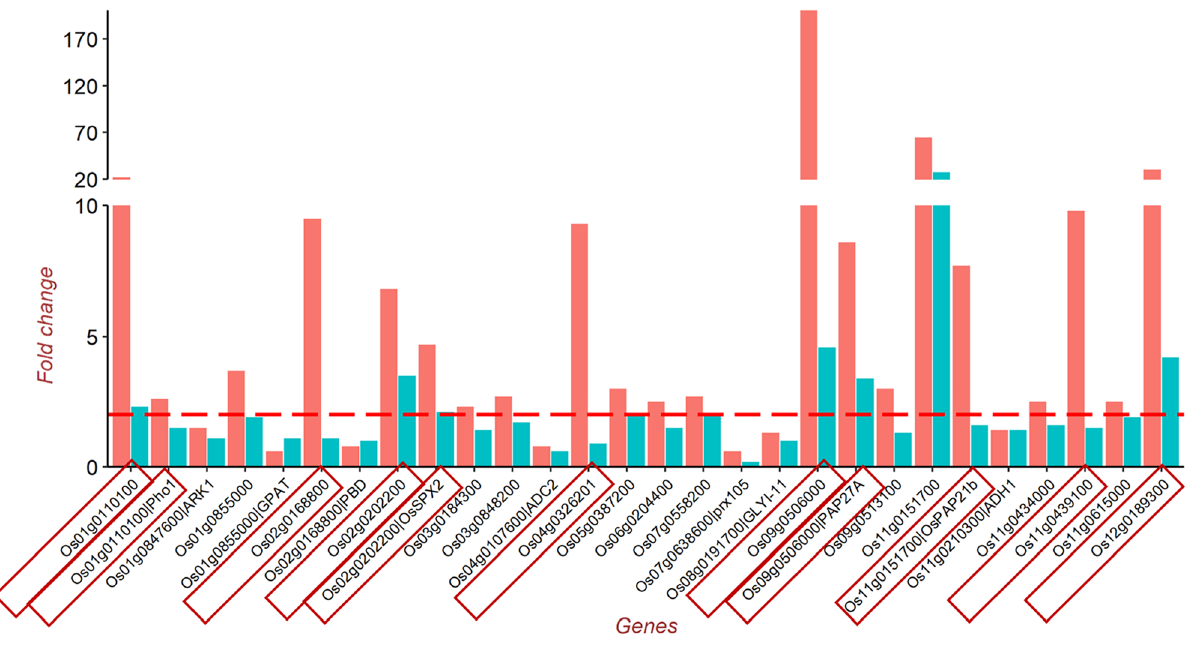
Figure 8. Fold change of the genes that enriched P-stress related GO terms in DJ123 under HPS treatment. Fold change was calculated by dividing the transcript abundance under HPS treatment by that under the HPC treatment in genotype-wise. The red line represents two-fold up-regulation of the corresponding gene in HPS compared to that in HPC. The red rectangular boxes highlight the genes, which are overdriven by DJ123 compared to